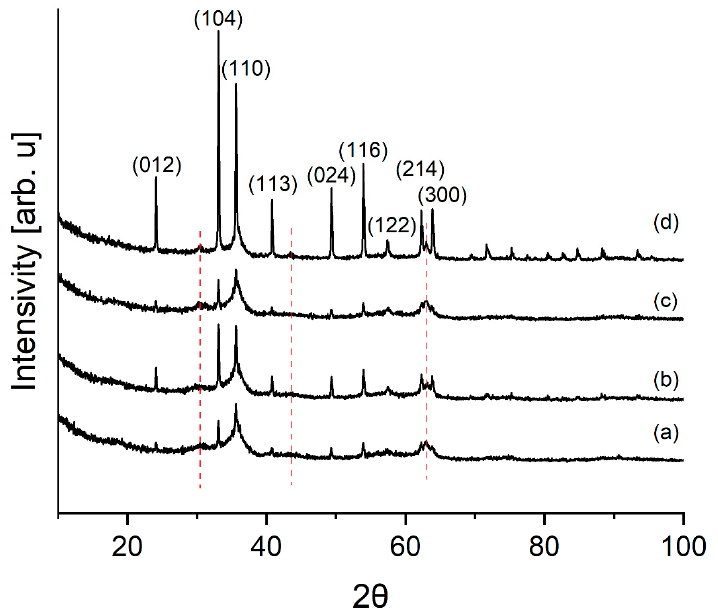
Figure 3. XRPD pattern of laboratory pigment samples: ( a ) CZ 10%, ( b ) CZ 21%, ( c ) CZ 28%, ( d ) CZ 14%. Red lines mark the remnants of geothite.